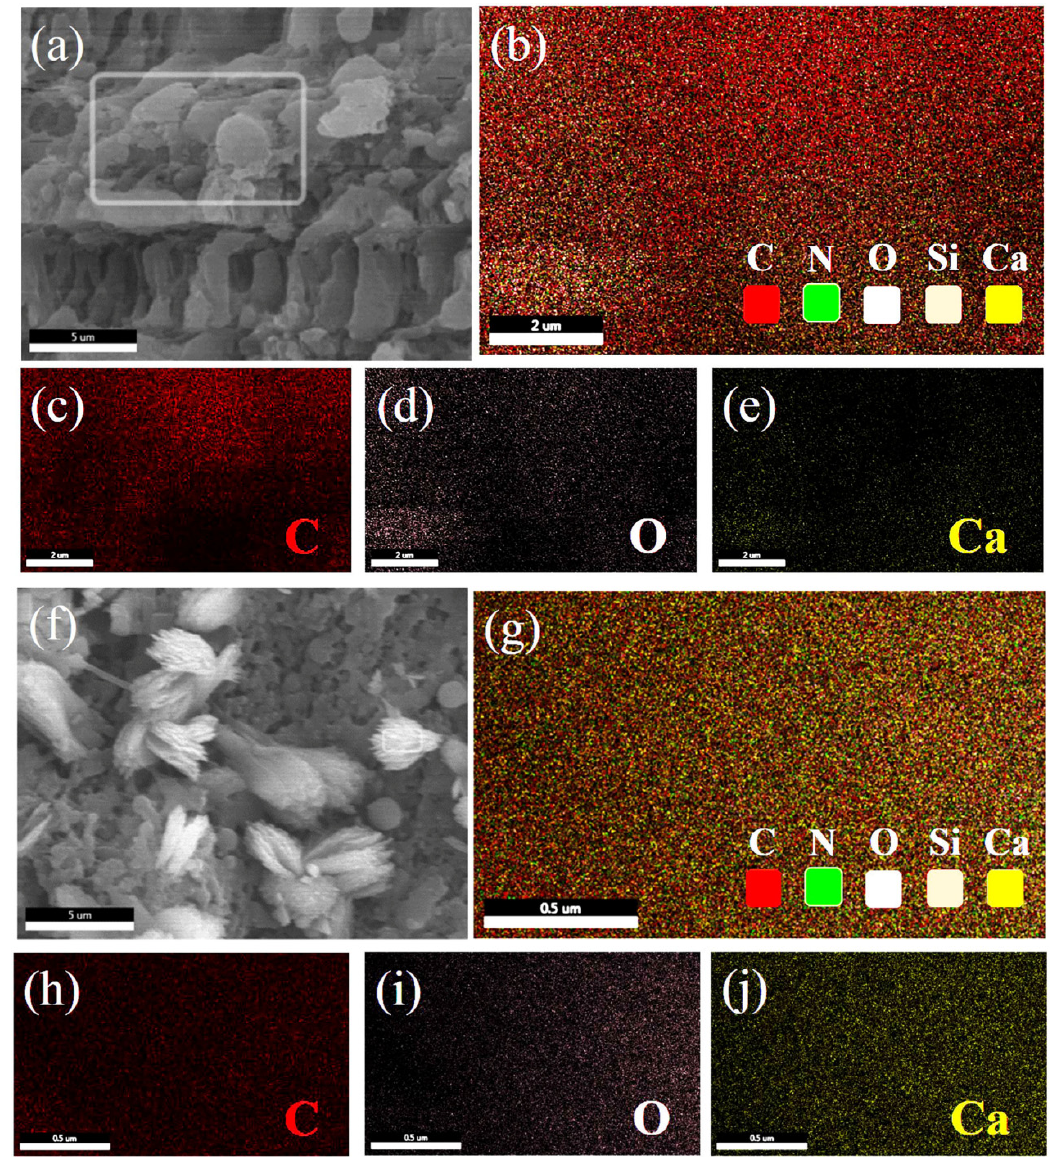
Figure 4. SEM images of ( a ) CaSiO 3 /ABS/TPU and ( f ) Ca-MOF/ABS/TPU, EDS element mappings of ( b – e ) CaSiO 3 /ABS/TPU and ( g – j ) the crystal on the Ca-MOF/ABS/TPU surface.